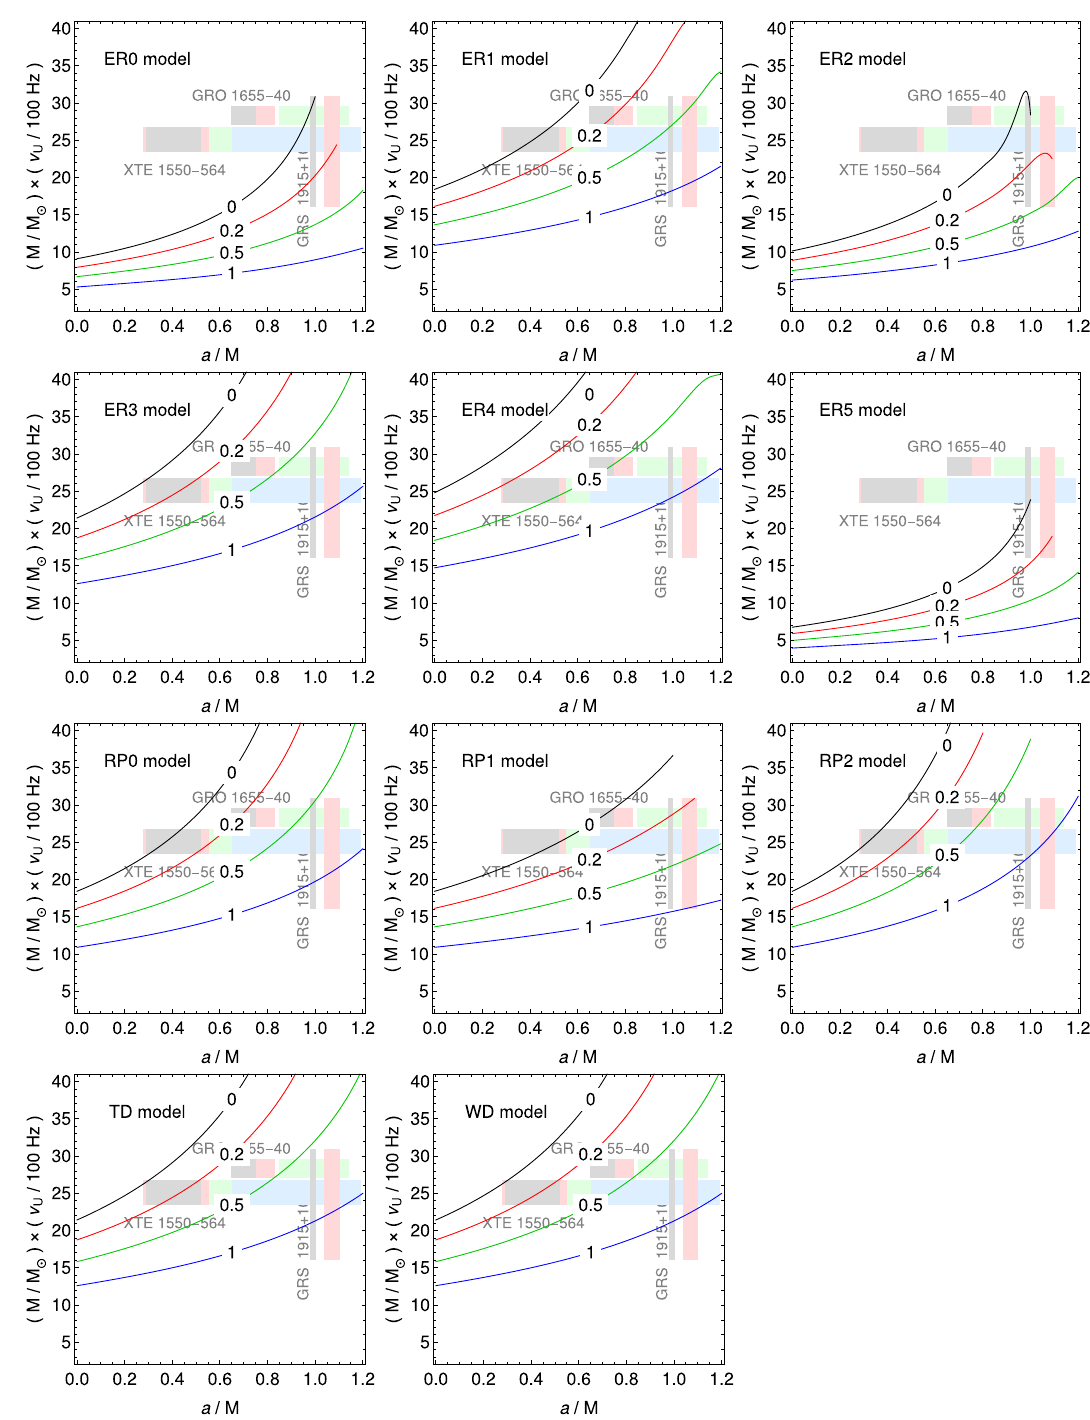
Fig. 5 Fitting of three microquasar sources with different HF QPOs models. On the horizontal axis the BH spin a / M is given, while on the vertical axis we give BH mass M divided by observed upper HF QPOs frequency μ U . Gray boxes are the values of BH mass M and spin